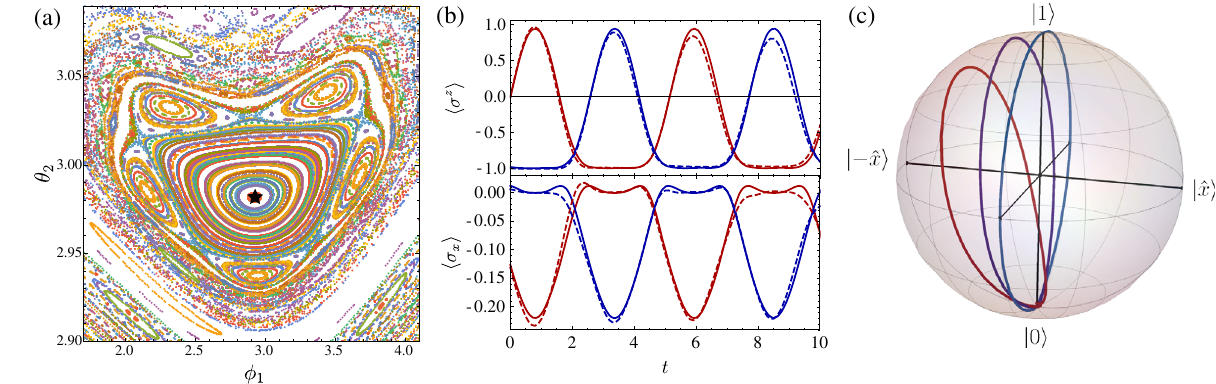
0 . 225 at ð θ (cid:3) 1 . 25 π ; _ θ 0 Þ and h H i ¼ 0 reveals mixed phase space with large regular regions. FIG. 5. (a) Poincar´e section for μ 1 < 1 ¼ z ¼ The Poincar´e section is obtained by initializing the system on a grid of points with the step δθ 2 ¼ δϕ 2 ¼ 8 × 10 − 3 and numerically integrating the evolution up to a time t ¼ 3000 using the NDS olve routine in Mathematica . (b) Comparison between TDVP predictions 0 . 225 ) on the periodic trajectory (solid lines) and the exact dynamics of a 4 × 4 lattice with for the dynamics of local observables ( μ z ¼ periodic boundary conditions. (c) Bloch sphere visualization of the individual spin dynamics on the TDVP trajectory. The trajectory on 0 . Nonzero chemical potential μ 0 . 225 , 0.65 causes a progressive tilting of the the big meridian corresponds to the case μ z ¼ z ¼ trajectory and the development of a knot around the south